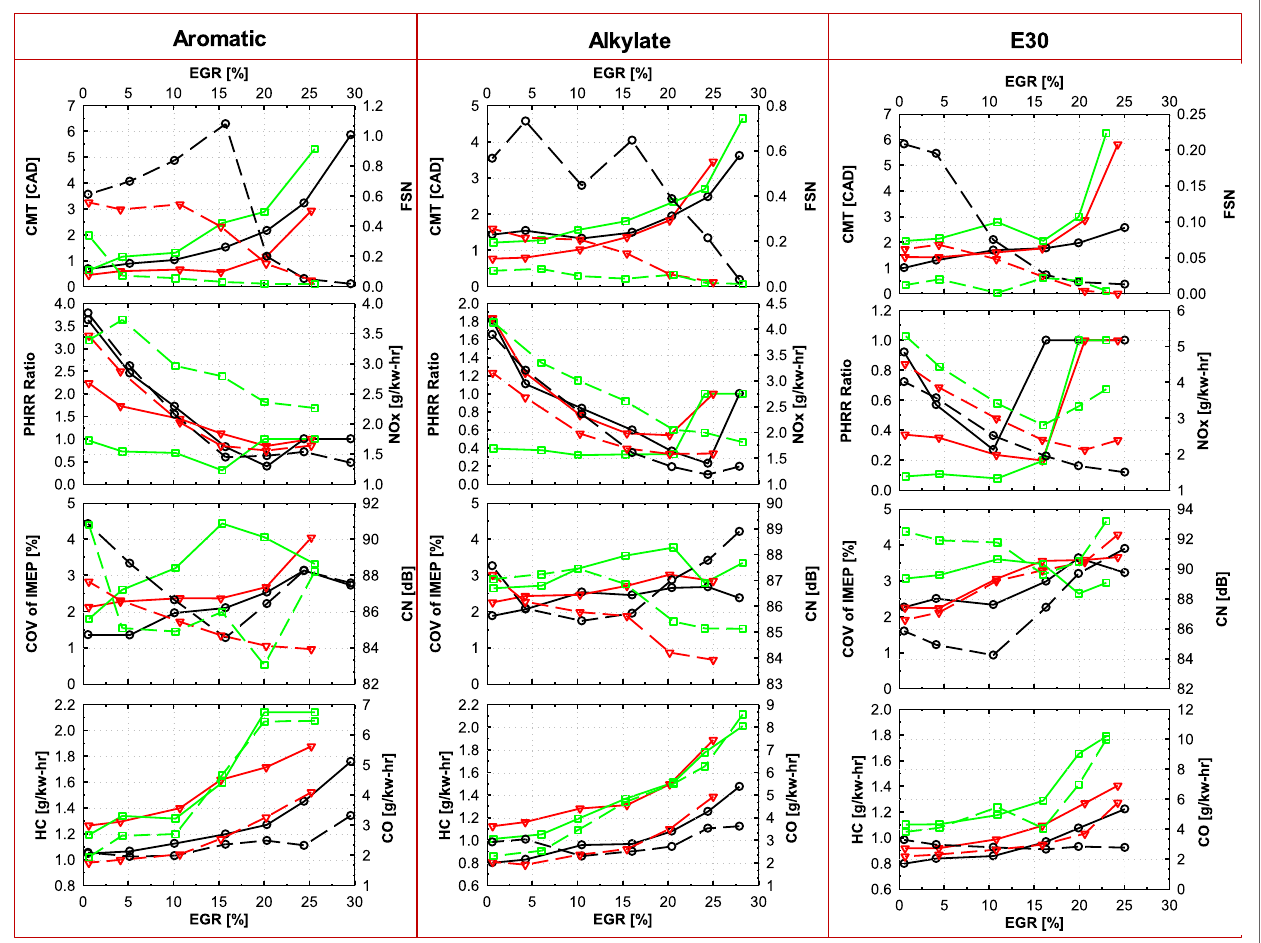
FigUre 7 | Combustion and emission of fuels at different λ -Exhaust gas recirculating (EGR) conditions with λ = 1.6 (black), 1.8 (red), and 2.0 (green). Solid lines are shown for y 1-axis (left). Dashed lines are shown for y 2-axis